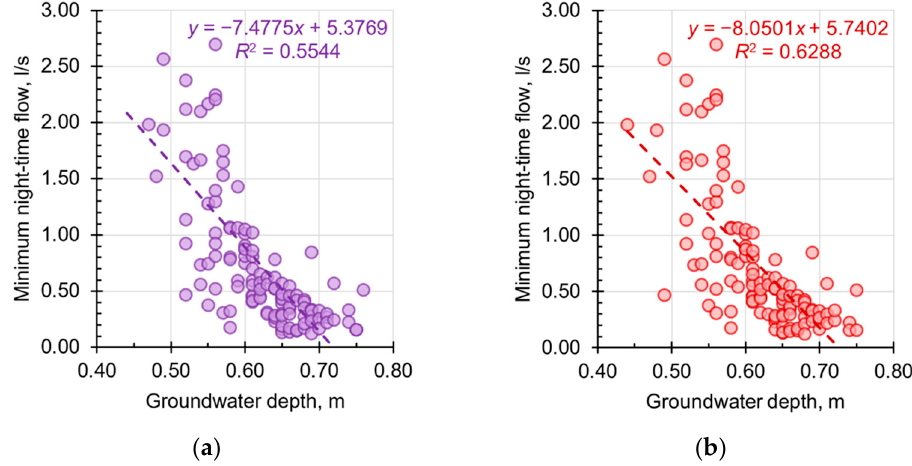
Figure 7. Scatter plots with trendlines and regression equations for SC5: ( a ) w/o offset; ( b ) w/offset.